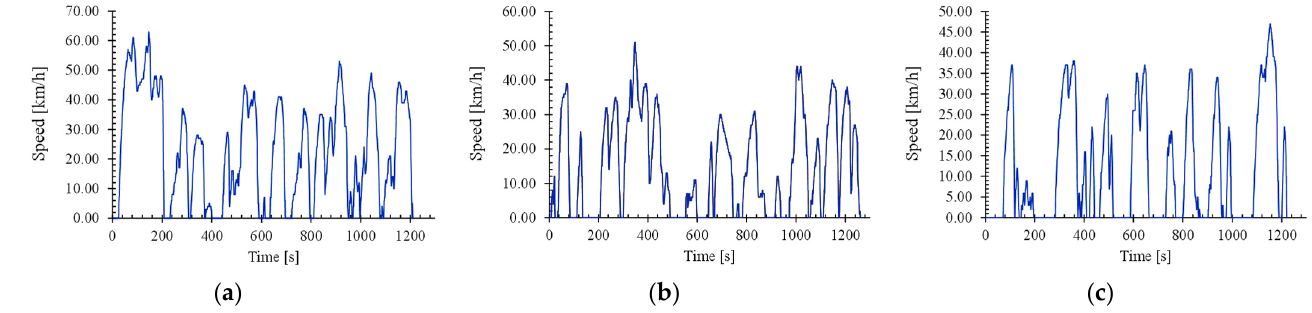
Figure 8. CircuitoTec representative Driving Cycle for ( a ) low SFC, ( b ) typical SFC, and ( c ) high SFC scenarios.